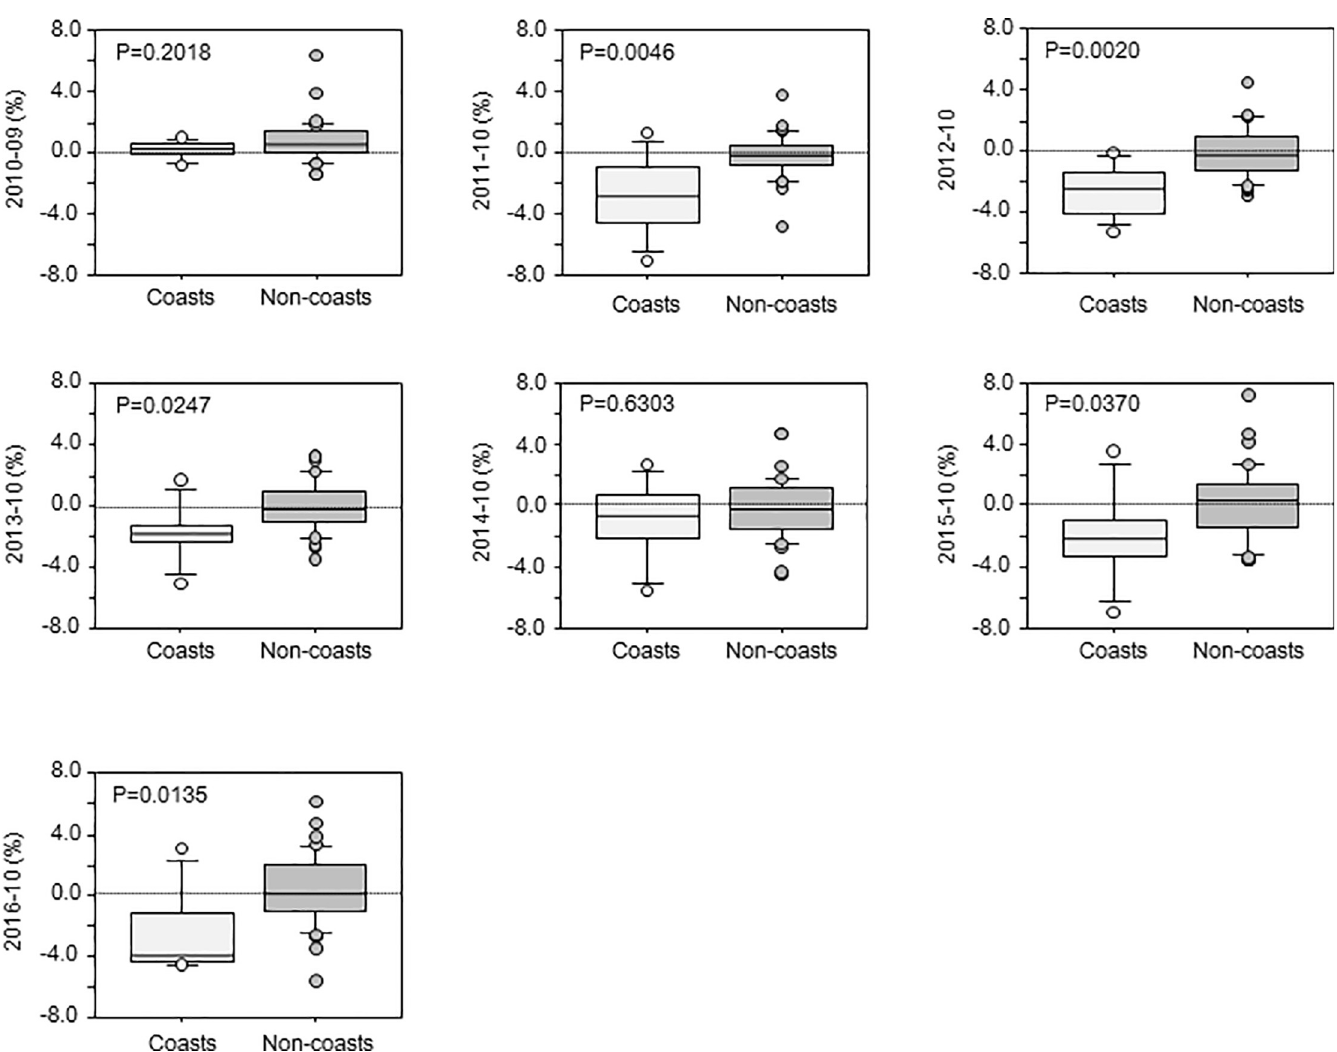
Fig 5. Comparison of the change in the cervical cancer screening rate in coastal and non-coastal regions. The bar graph shows the median value of differences in the CCS-R between before and after the Great East Japan Earthquake (%). Coast, nine coastal regions; Non-coasts, 36 non-coastal